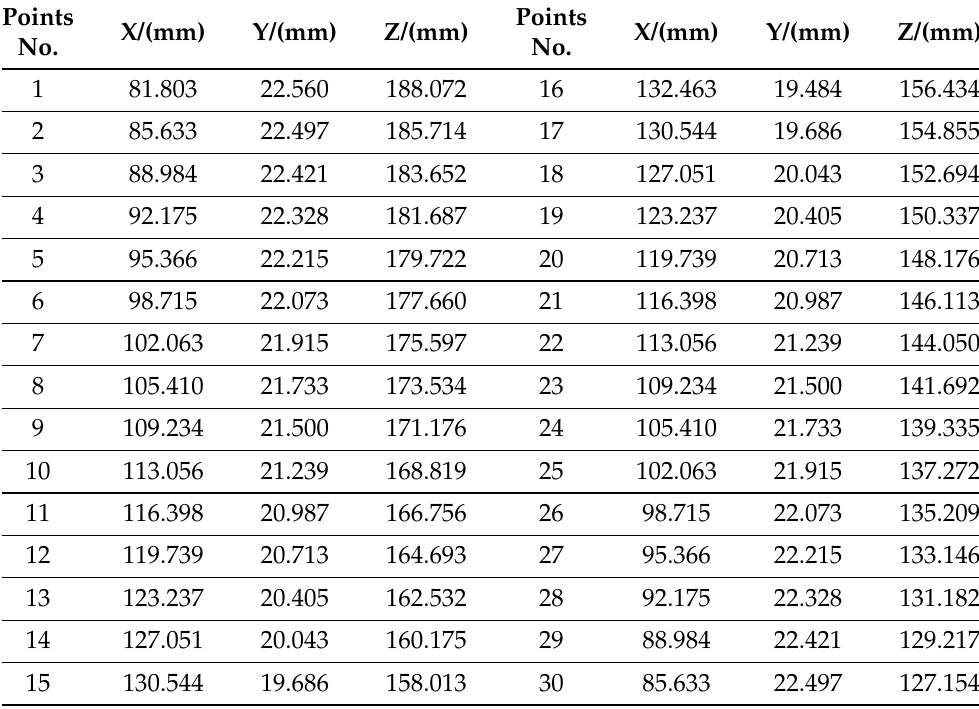
Table A4. The coordinates of the 30 measured